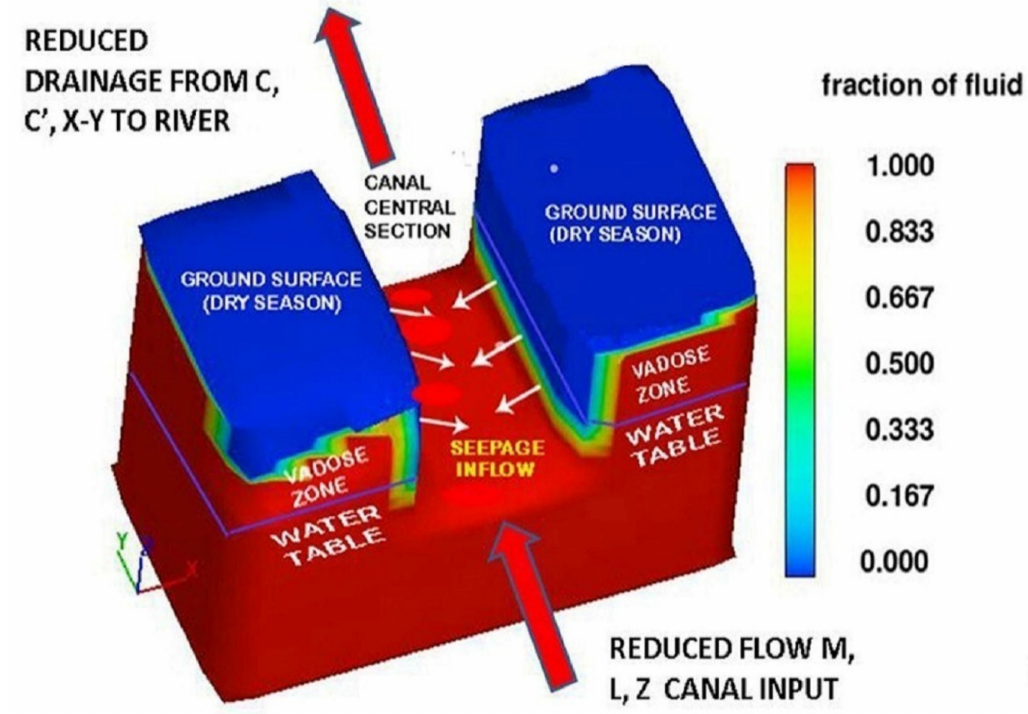
Figure 12. Dry season (Case 2) fluid fraction results for the monumental center with decreased water supply from spring-supplied canals; rainfall infiltration and seepage limited by large paved and roofed areas of the ceremonial